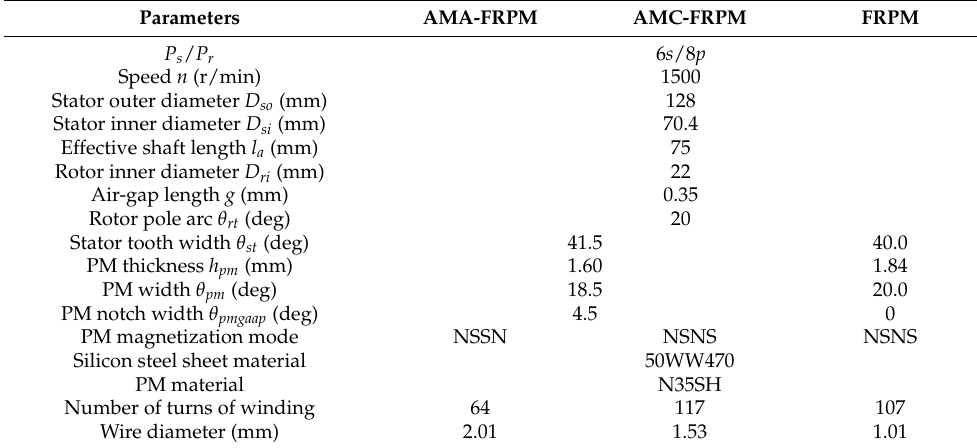
Table 2. The parameters of three FRPM